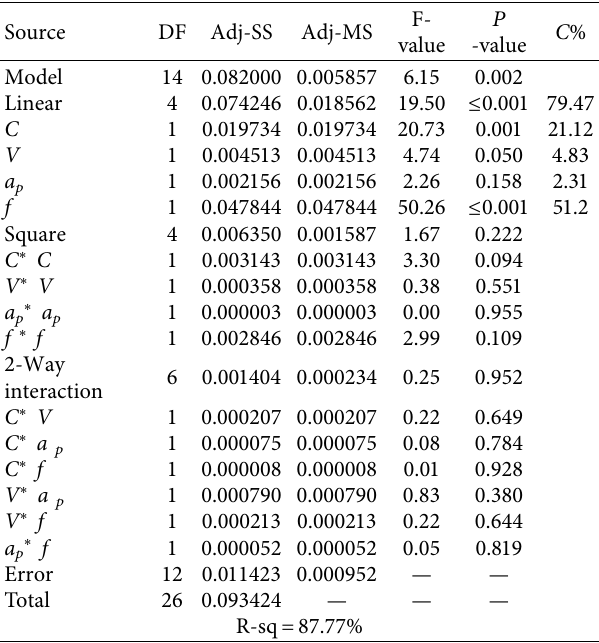
Table 5: Analysis of variance for surface